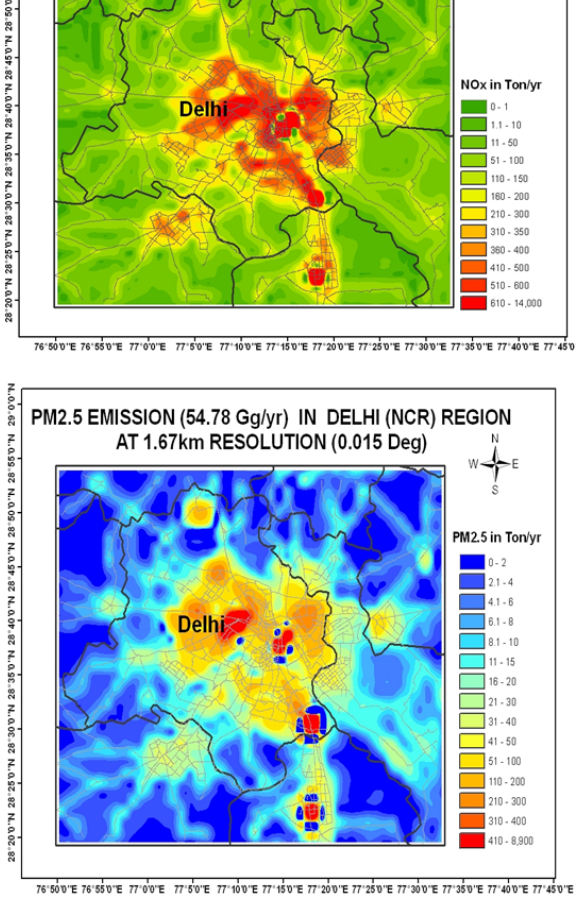
Figure 2. Emission distributions of NO x (top) and, PM 2 . 5 in Tonnesyr − 1 over